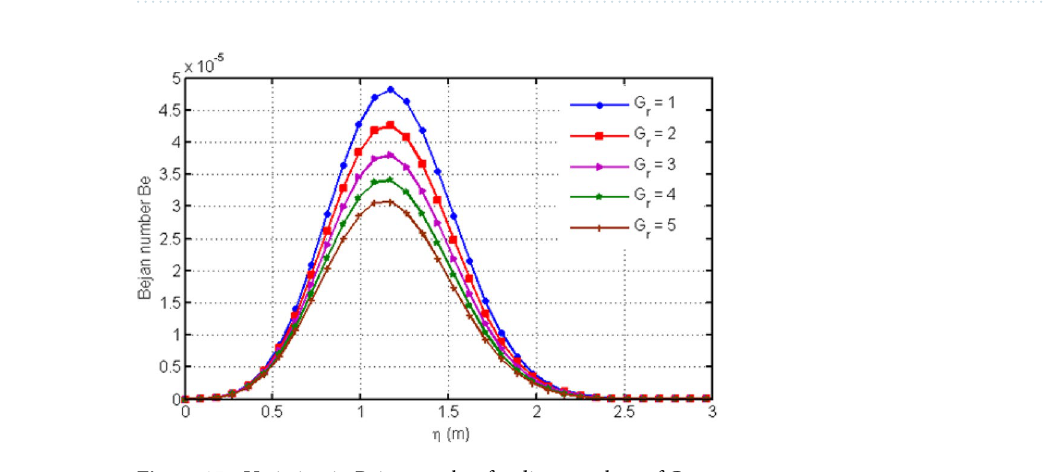
Figure 14. Variation in Bejan number for diverse values of C 6 H 9 NaO 7 parameter β .